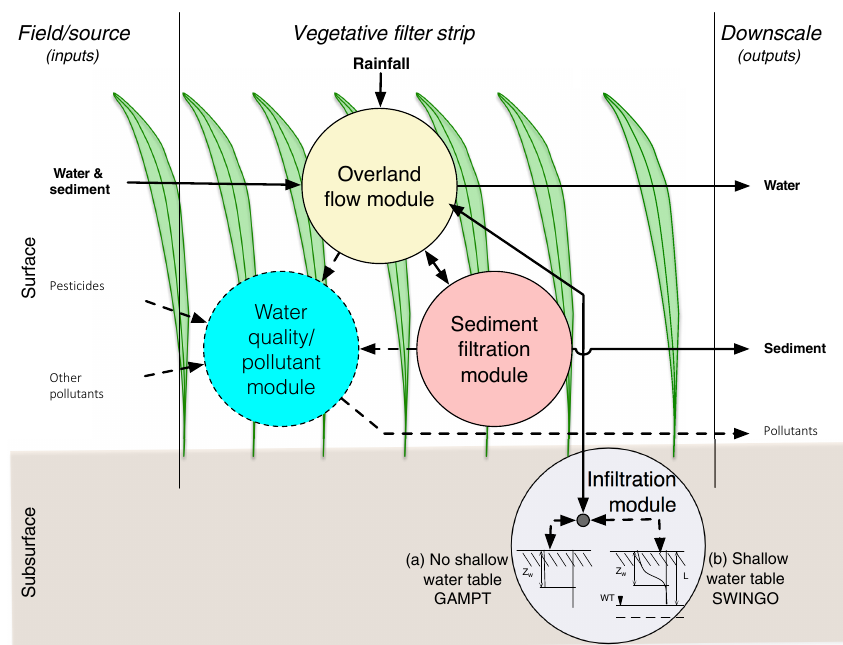
Figure 1. Conceptual model of VFSMOD showing the coupling between overland flow, soil infiltration and redistribution, sediment, and pesticide components. Solid lines indicate required processes and their interactions, and dashed lines are optional, user-selected components. The selection of infiltration under either (a) a deep water table (extended Green–Ampt, GAMPT), or (b) a shallow water table (SWINGO) is